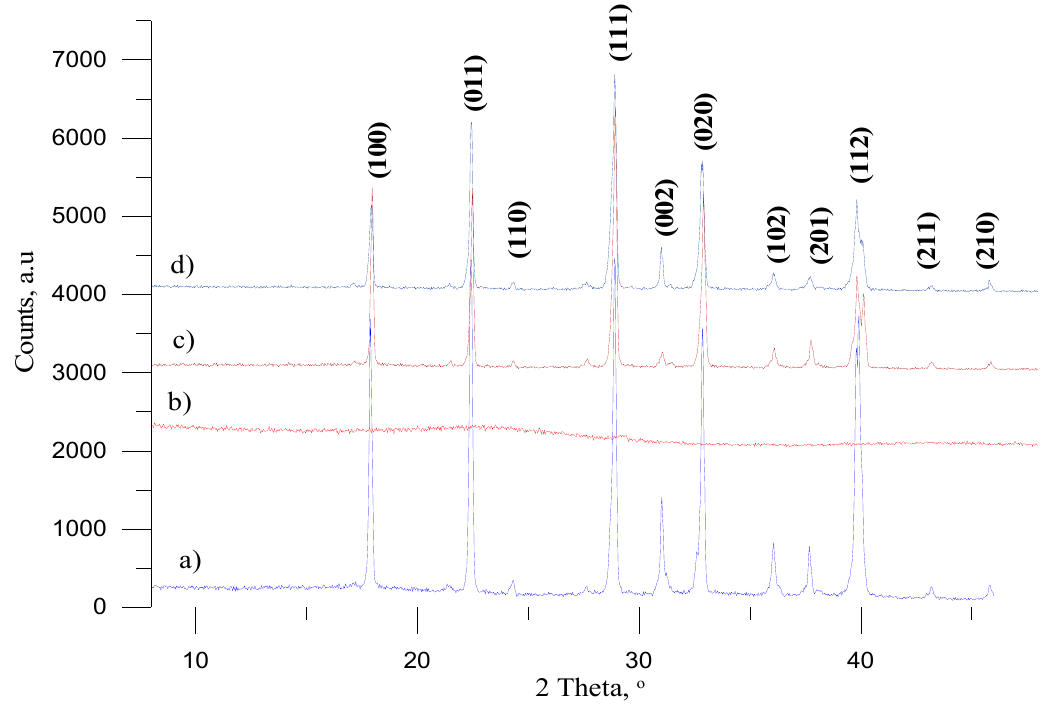
Figure 4. XRD profiles of: ( a ) ANFO, ( b ) MC, ( c ) non-ideal explosive with ca. 1.0% of MC, and ( d ) non-ideal explosive with ca. 3.0% of MC.